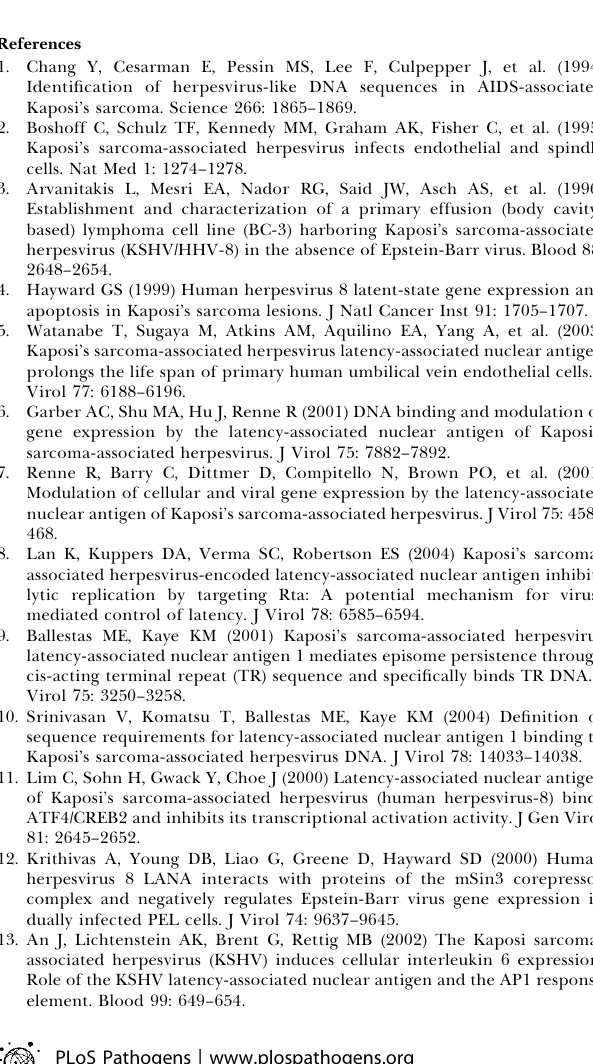
Figure S2. LANA Attenuates the Inhibition of p53 and VHL to Regulate the Transcriptional Activities of HIF-1 a (A) BJAB, (B) 786-O, and (C) Saos-2 cells were cotransfected individually as indicated (10 l g of LANA, 5 l g of VHL, and 5 l g of p53 ). The multimeric hypoxia response element (HRE) promoter with luciferase reporter was used to detect the transcriptional activity of